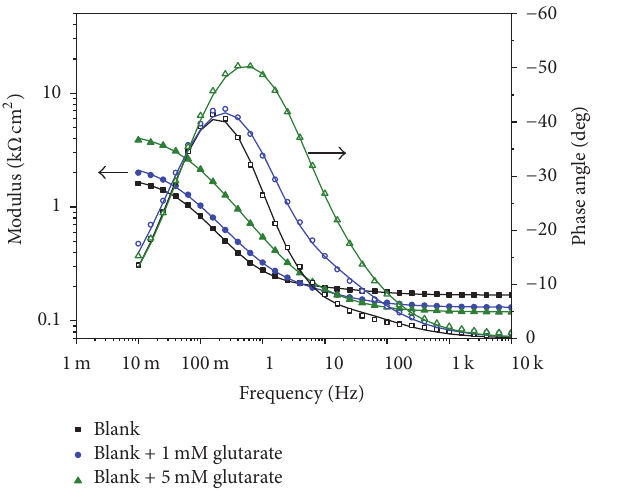
Figure 5: Bode plots of carbon steel in aerated 0.02 M NaCl solution with additions of sodium glutarate ≥ 32 mM. The solid lines correspond to fitted